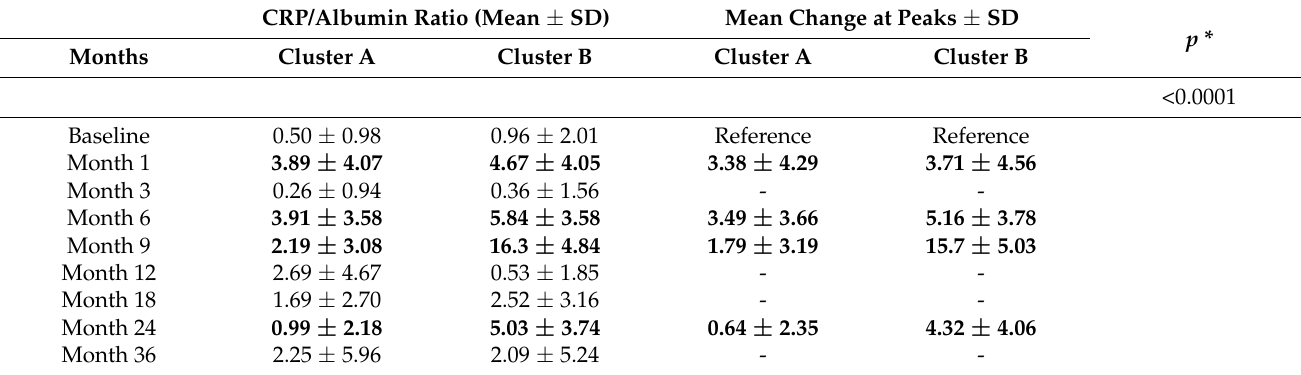
Table A1. Mean values of CAR according to clusters during the study